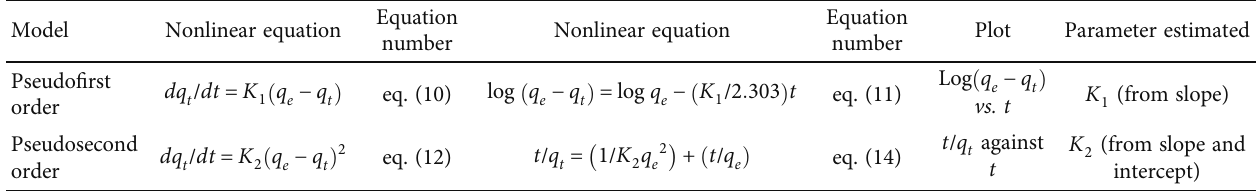
Table 2: Nonlinear and linearized adsorption kinetic model with their